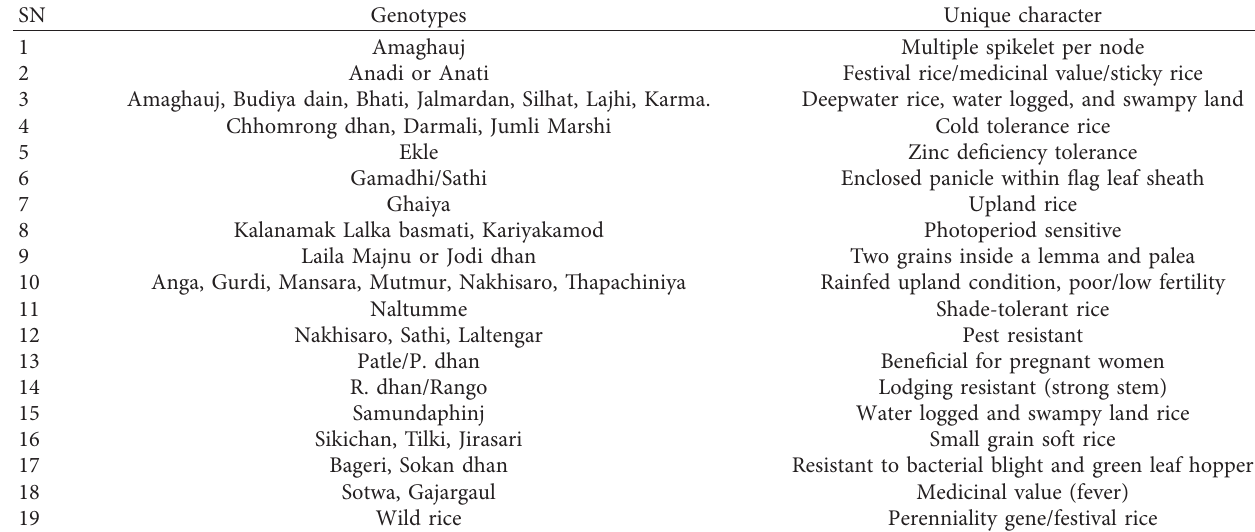
Table 3: Genotypes with their unique characters found in Nepal [36,